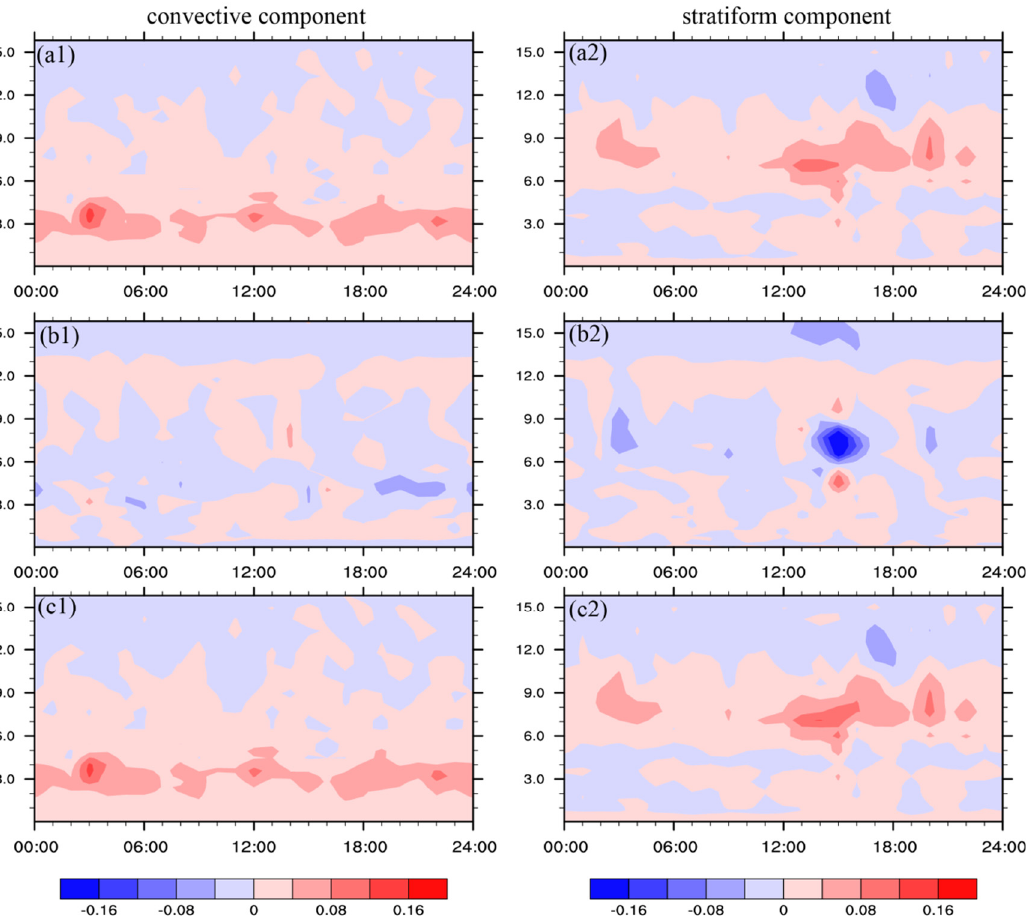
Figure 9. Diurnal composite of ( a1, a2 ) the tendency of the perturbation kinetic energy ( ∂ K (cid:48) ), ( b1 , b2 ) barotropic term ( G u ( K , K (cid:48) ) + G v ( K , K (cid:48) ) ), and ( c1 , c2 ) G T ( K (cid:48) ) + G qv ( K (cid:48) ) + G ql ( P (cid:48) ) in the 3D model runs in ( a1 , b1 , c1 ) convective regions and ( a2 , b2 , c2 ) stratiform regions. The units are 10 − 1 J m − 2 s − 1 for the barotropic conversion term and J m − 2 s − 1 for the other terms.